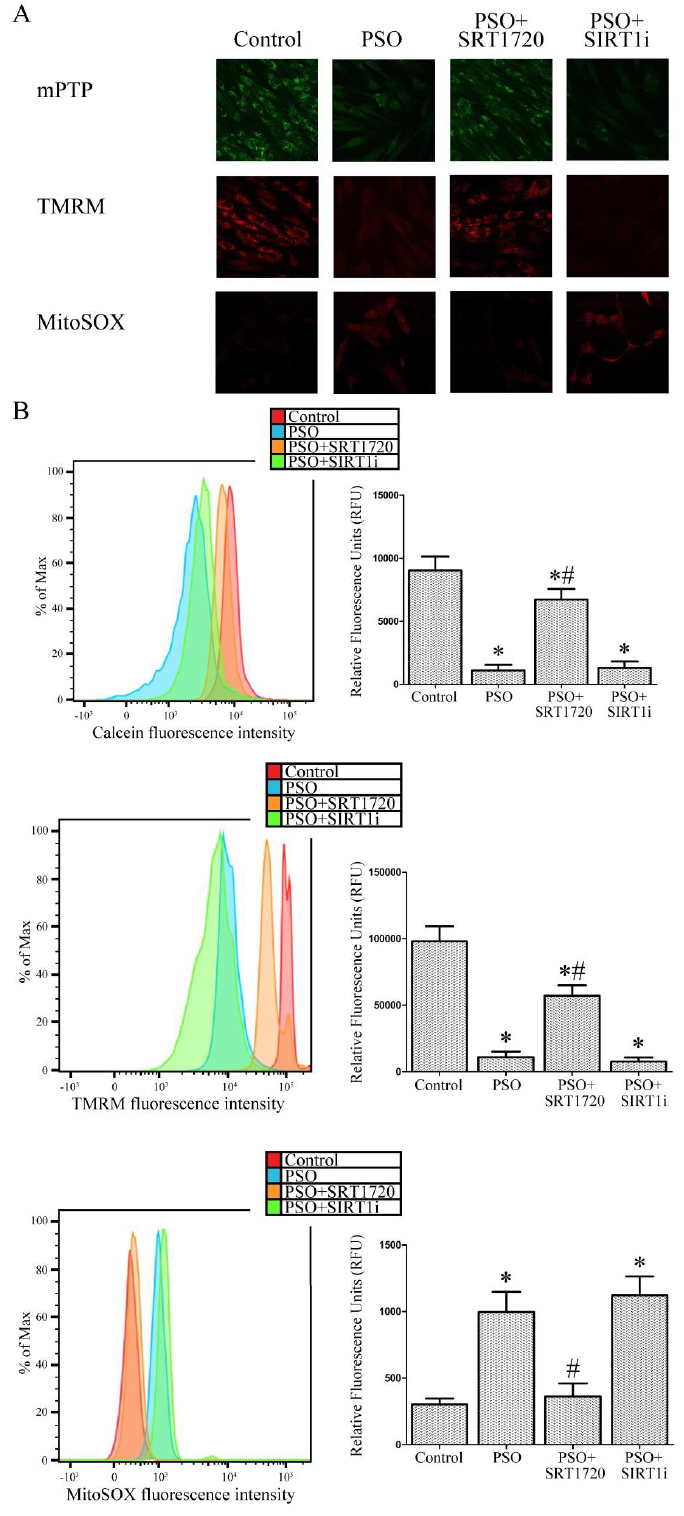
Figure 4. ( A ) Confocal microscope analysis (63× magnification) and ( B ) FACS analysis